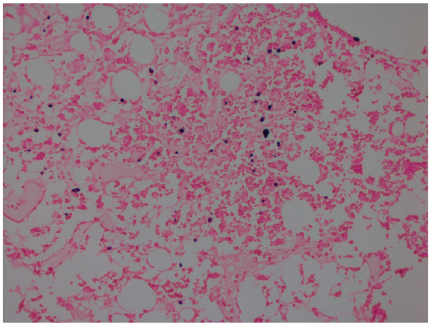
Figure 3: 40x of the EBER-ISH (EBV-encoded RNA-in situ hy- bridization) stain demonstrating EBV activity in the bone